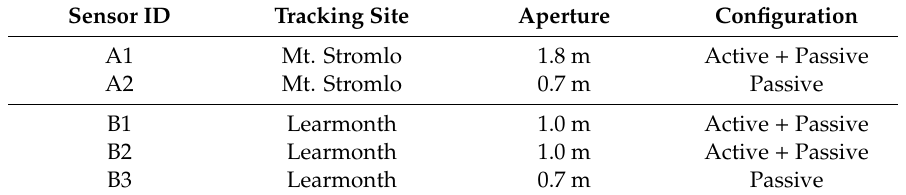
Table 3. The configurations of two tracking sites [15].